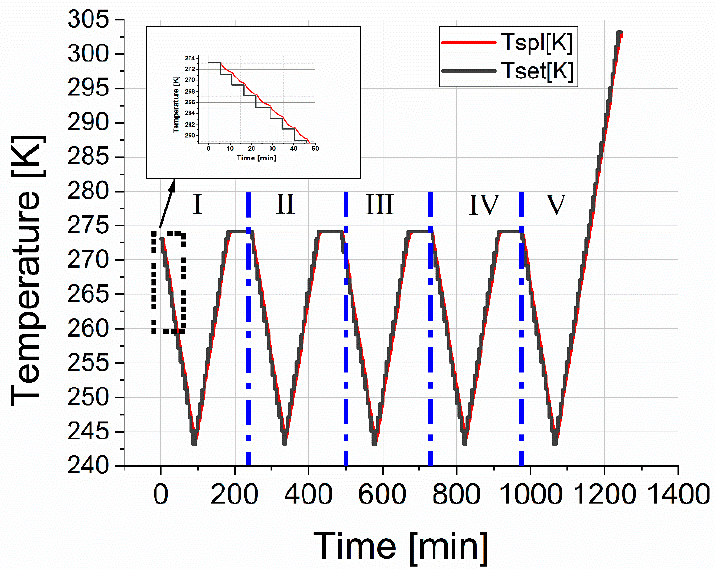
Figure 8. Temperature protocol for cooling and heating the measuring cell during five measurement cycles. The red line is the cell temperature; the black line is the setpoint temperatures.